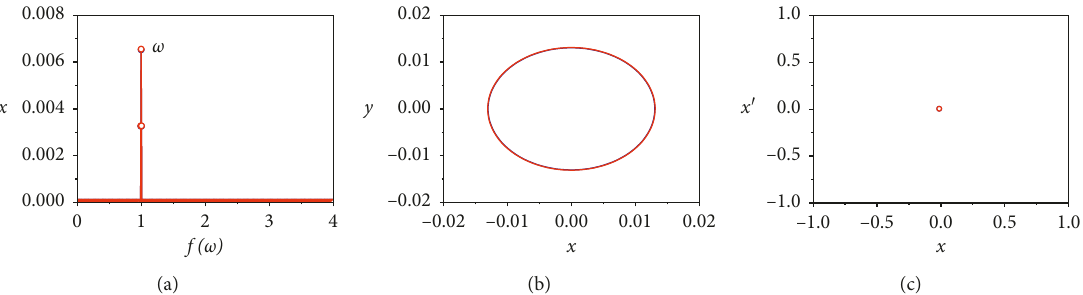
Figure 7: The response of the rotor/seal system at s � 2. (a) The frequency spectrum of the x coordinate. (b) The orbit of the rotor. (c) The Poincar´e map of the x coordinate.